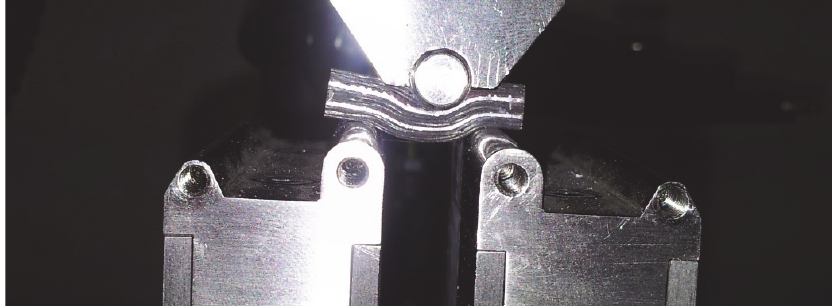
Figure 2: A specimen during the three-point bending